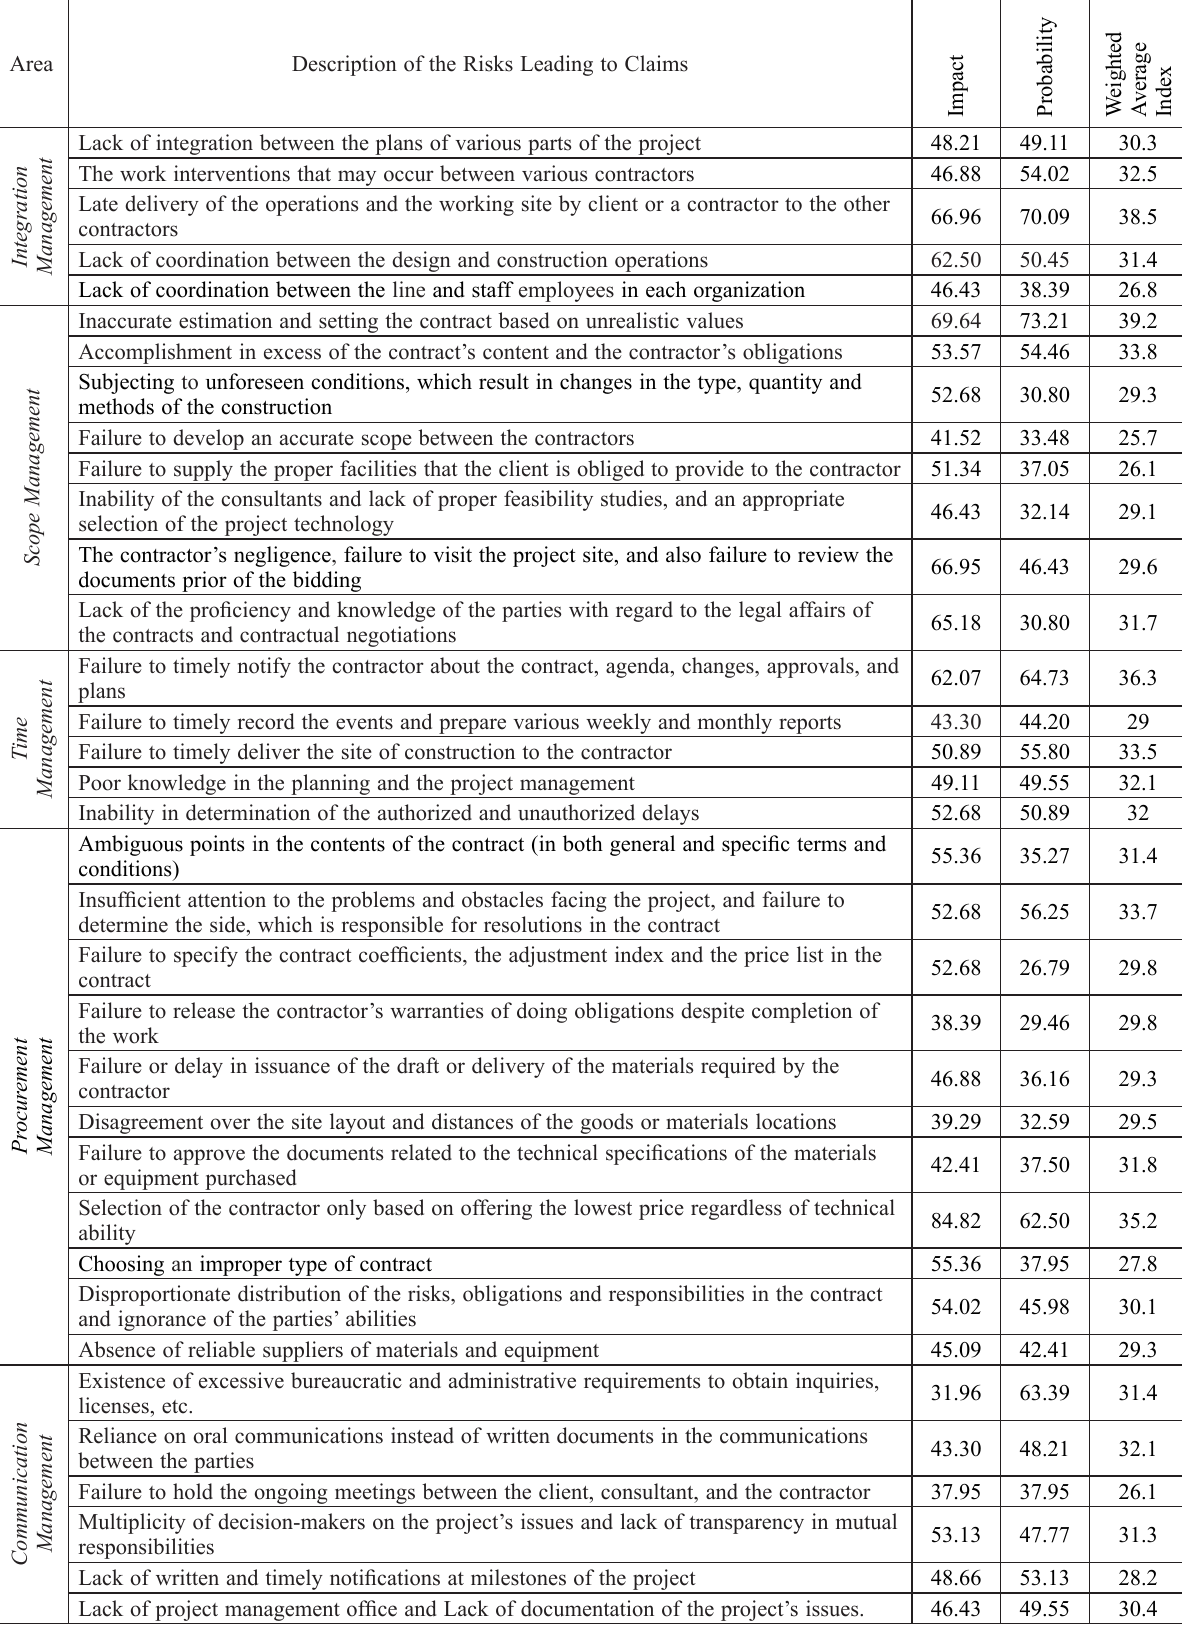
Table 1. Different causes of the claims in Iran construction projects